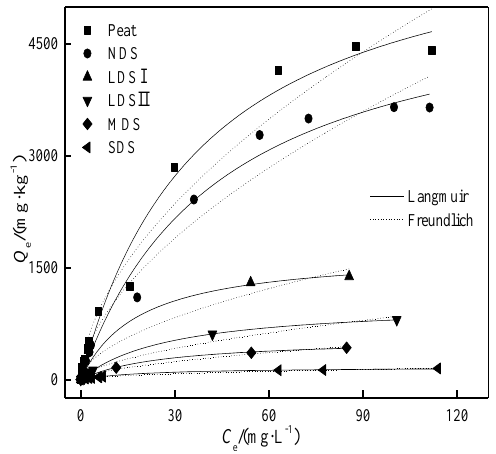
Figure 4. The Cd adsorption isotherms on the six selected soils. Table 3. The parameters based on Langmuir and Freundlich model fittings for Cd adsorption isotherms with the six selected soils and the